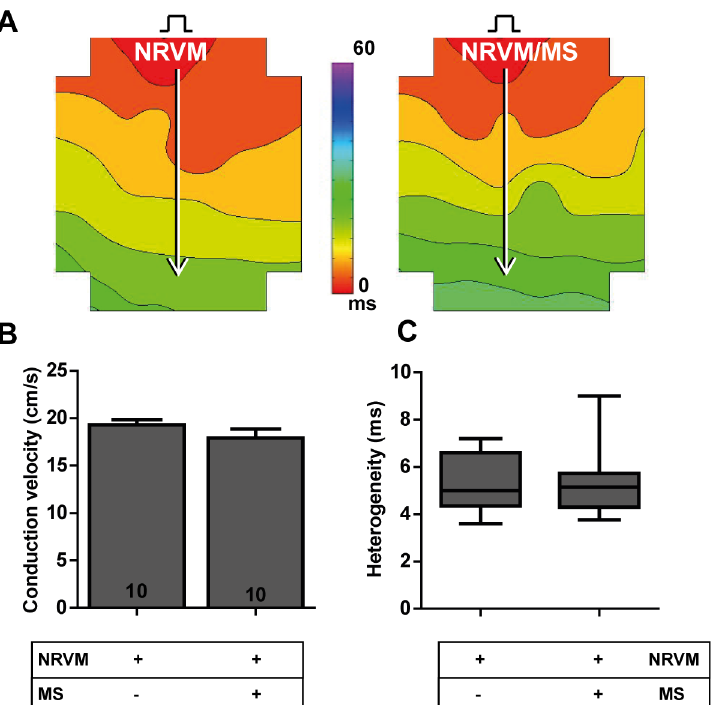
Fig 4. Effects of recombinant human collagen-based microspheres on NRVM monolayers. A: An activationmap of a monolayerof NRVM (left) and a monolayerof NRVM cultured with microspheres (right). Conduction velocitiesare determinedalong the white arrows perpendicular to isochronal (black) lines. The effects of culturingbare microspheres on monolayers of NRVM on B: conductionvelocity and C: conduction heterogeneity. Number of replicates per experimental conditionis indicatedin the bar-graphs. Abbreviations; MS: microspheres and NRVM: neonatalrat ventricular myocytes.